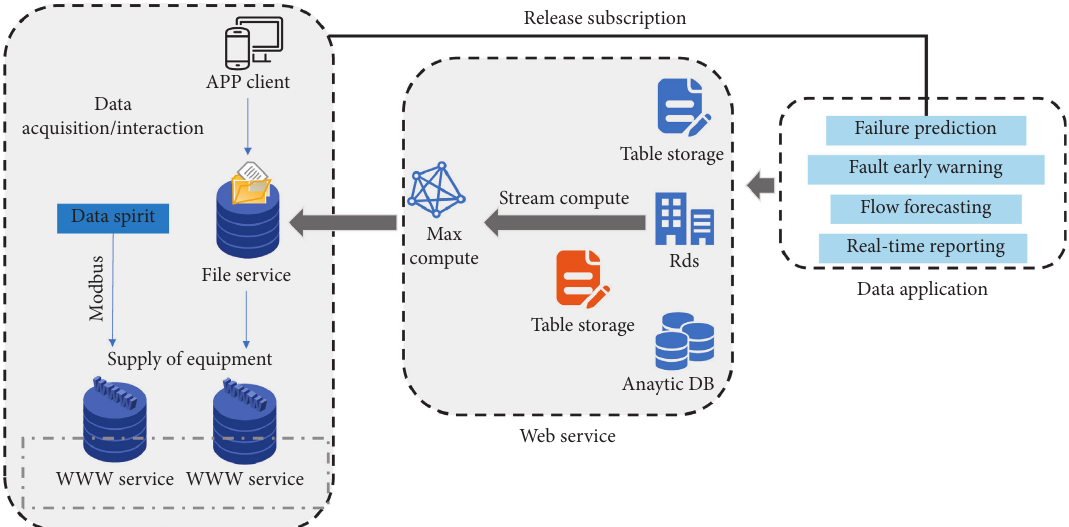
Figure 5: Structure of the automated user classification system.